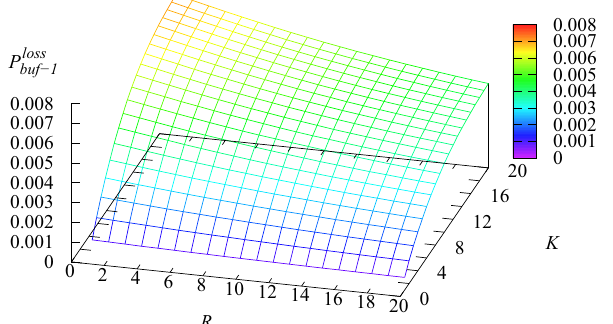
of an arbitrary request from the first buffer on K buf − 1